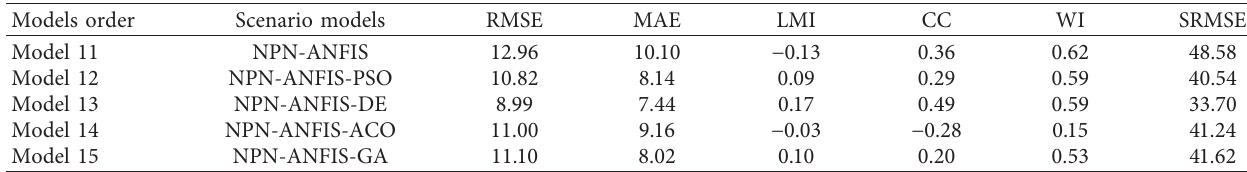
Table 4: The statistical evaluation of the developed hybrid and original ANFIS for the scenario of the non-preprocessed and normalized (NPN) dataset over the testing phase of the modeling.